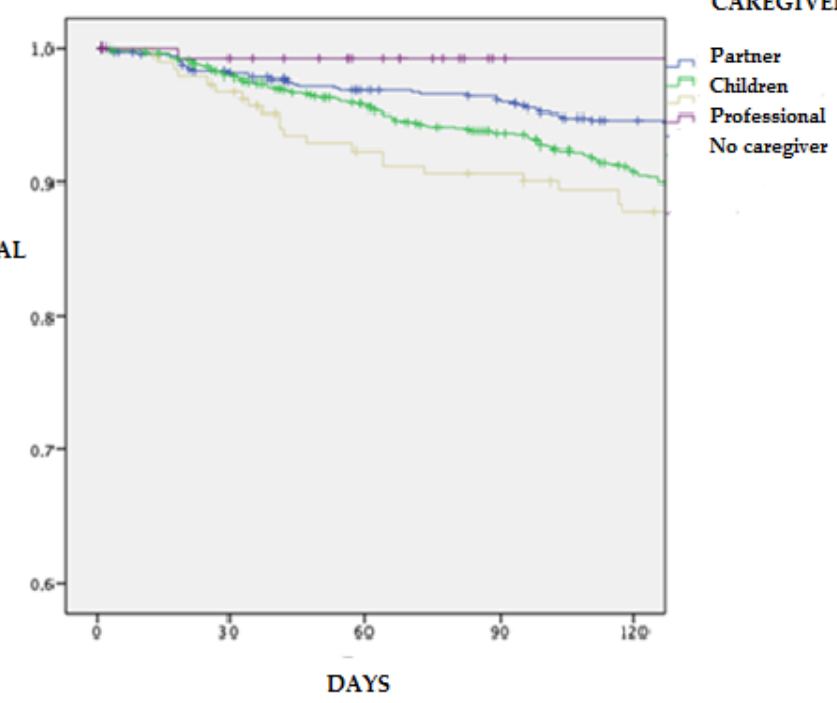
Figure 2. Survival analysis for mortality in patients with HF according to caregiver type at 120-day follow-up.